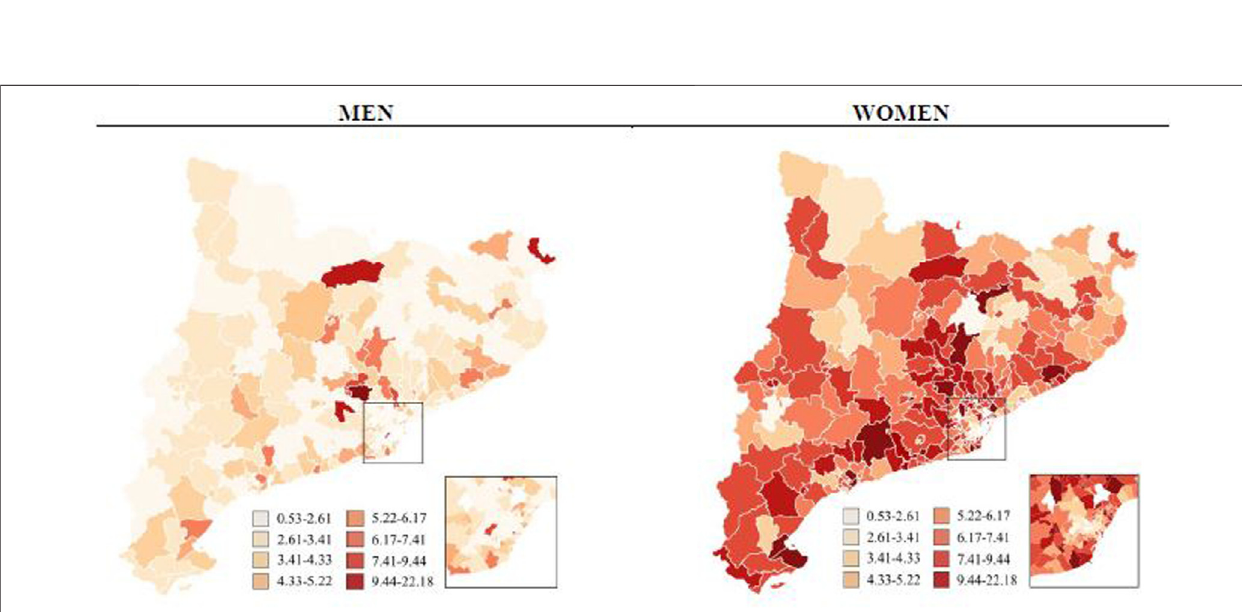
Frontiers in Pharmacology |